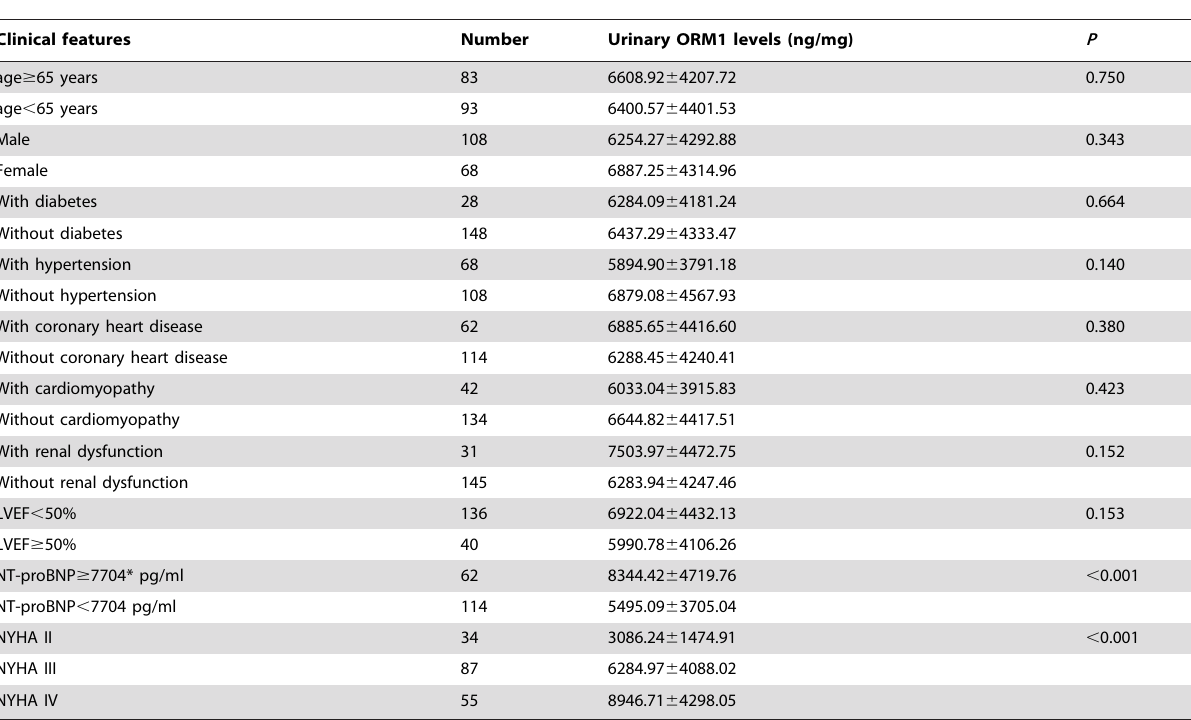
Table 4. Relationship between urinary ORM1/Cr level and chronic heart failure.